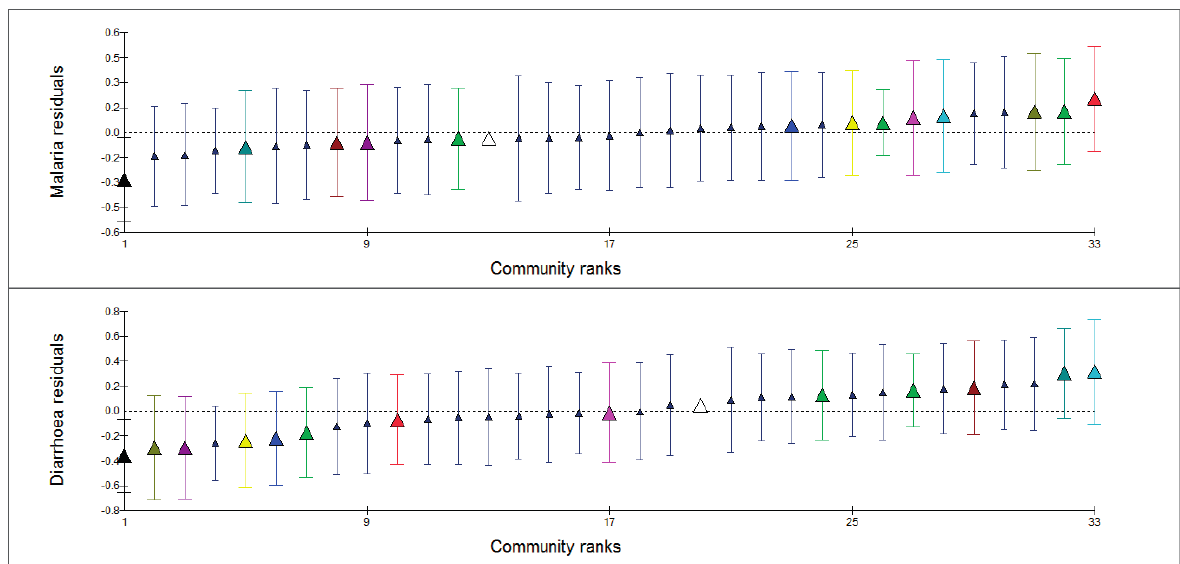
Figure 2. Caterpillar plot of household residuals for malaria and diarrhea prevalence. The dotted line is the mean of the estimated (shrunken) residuals, which is equal to zero (estimated or shrunken residual for group j is the residual obtained by multiplying the mean of the residuals of subjects in group j by a shrinkage factor. Shrinkage factor shrinks an observed group mean towards the centre of the population mean). The brushes represent 95% CI to the estimated residuals.